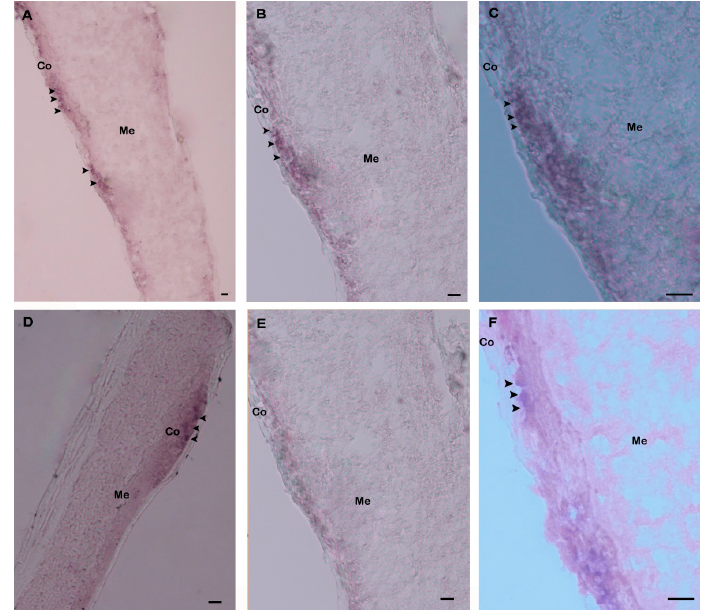
Figure 8. Expression of Hdh IGFBP-5 mRNA in the cerebral ganglion demonstrated by in situ hybridization. ( A ) Hybridization signals with an antisense probe are detected in neurosecretory cells (arrows) of the cortex region; ( B ) medium magnification of A; ( C ) high magnification showing hybridized Hdh IGFBP-5 mRNA in neurosecretory cells; ( D ) medium magnification showing hybridization signal in other parts of the cortex region; ( E ) no hybridization signal is detected after hybridizing with Hdh IGFBP-5 mRNA sense probe; ( F ) fast red counterstaining exhibiting hybridized neurosecretory cells. Co – Cortex; Me – Medullae. Scale bars, 100 µm.